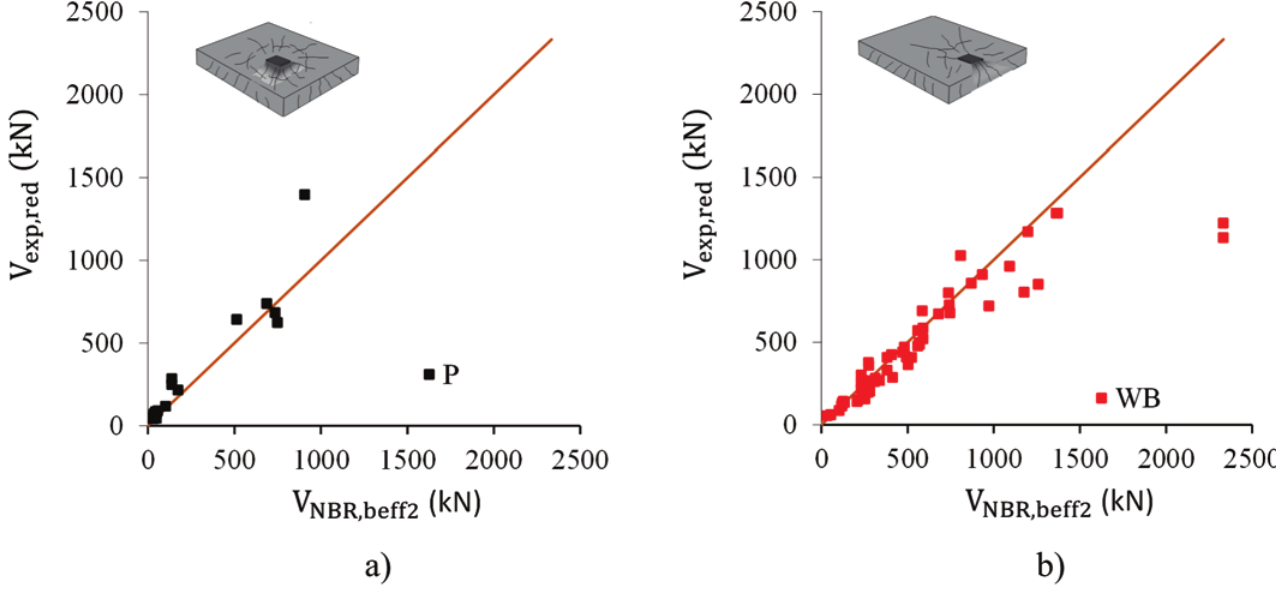
Evaluation of the one-way model of shear force strength by ABNT NBR 6118:2014 according to the failure mode of experiments: a) Punching (P), b) Wide Beam